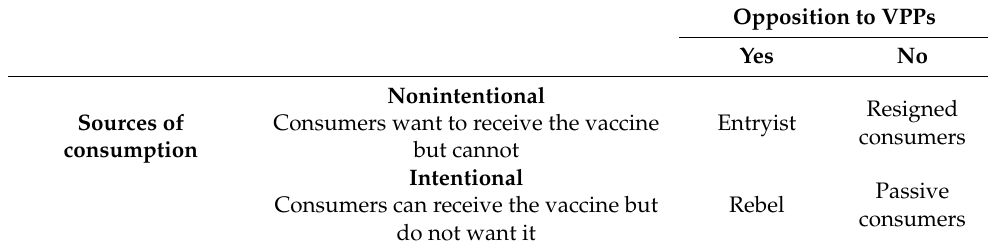
Table 3. Potential reactions to